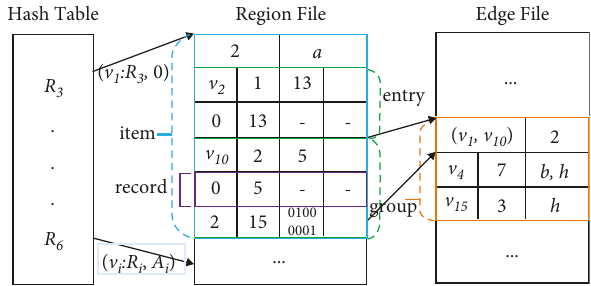
Figure 7: Generalized adjacent list